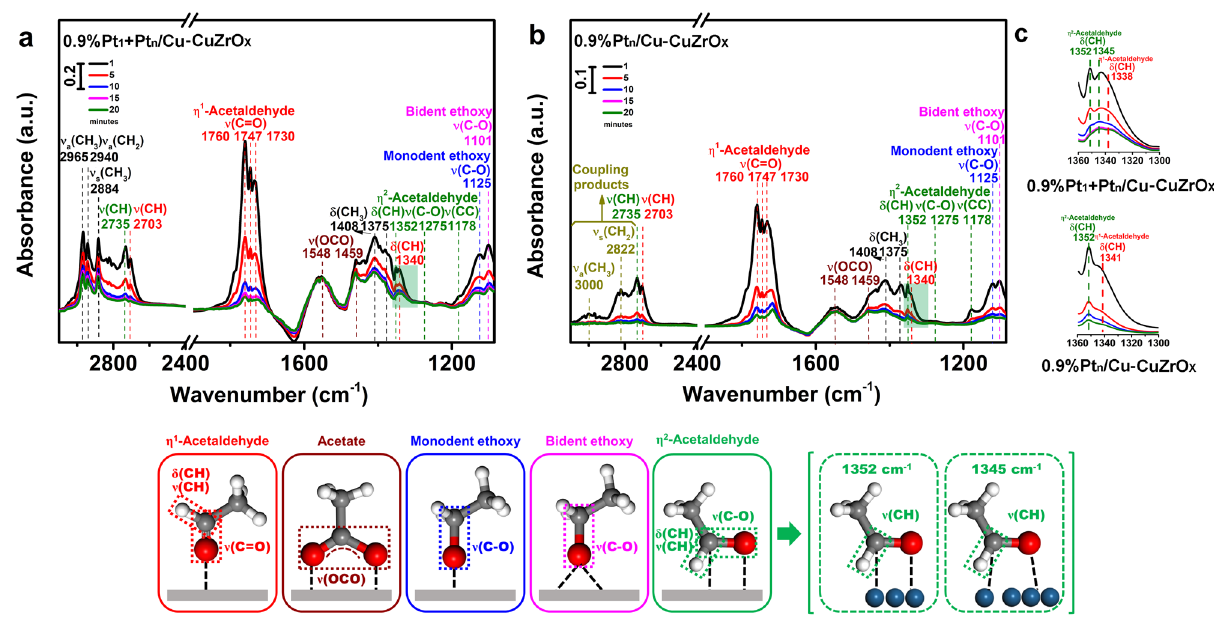
Fig.6|TheactivationoftheC=Obondsinaldehyde. InsituFT-IRspectraafterthe adsorption of acetaldehyde for30minfollowed bydesorption at desorptiontimes of 1, 5, 10, 15, and 20min (from top to bottom) on 0.9%Pt 1 +Pt n /Cu-CuZrO x ( a ), and